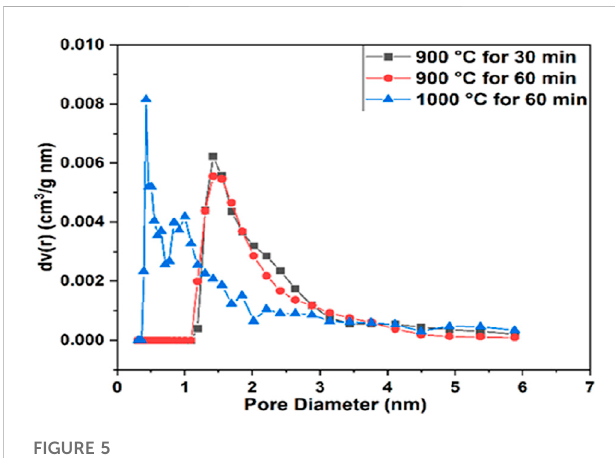
Pore size distribution of calcined CFBP.